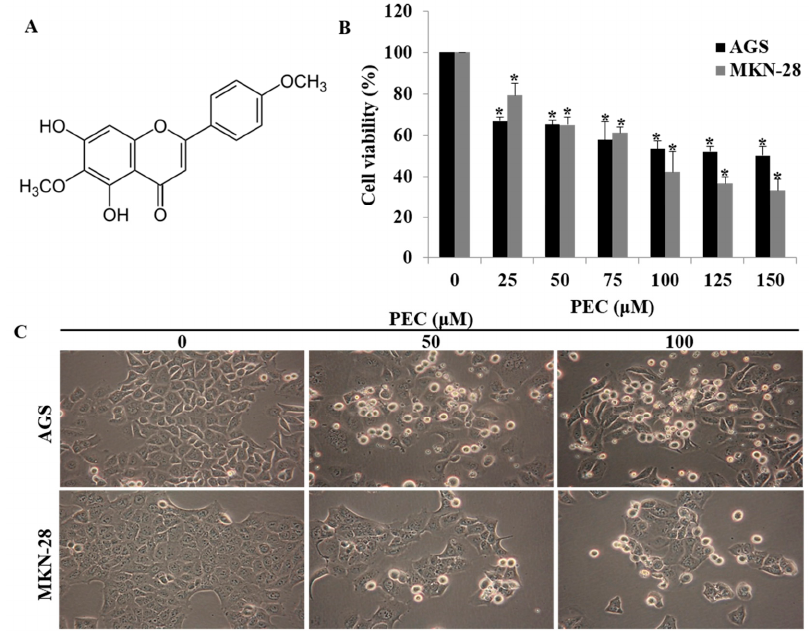
Figure 1. Effect of PEC on viability of human gastric cancer cells. ( A ) Structure of Pectolinarigenin (PEC). ( B ) AGS and MKN28 human gastric cancer cells were incubated with selected concentration of PEC (0–150 μ M) for 24 h. Results indicated that PEC significantly inhibited human gastric cancer cell population growth in a dose-dependent manner compared to non-treated (control group) cells. Results are expressed as the mean ± standard deviation (SD) of at least three independent experiments. Statistical differences were analyzed with Student’s t -test (* p < 0.05 vs. control). ( C ) Morphology of AGS and MKN28 cells was examined under light microscopy ( × 400) after treated with